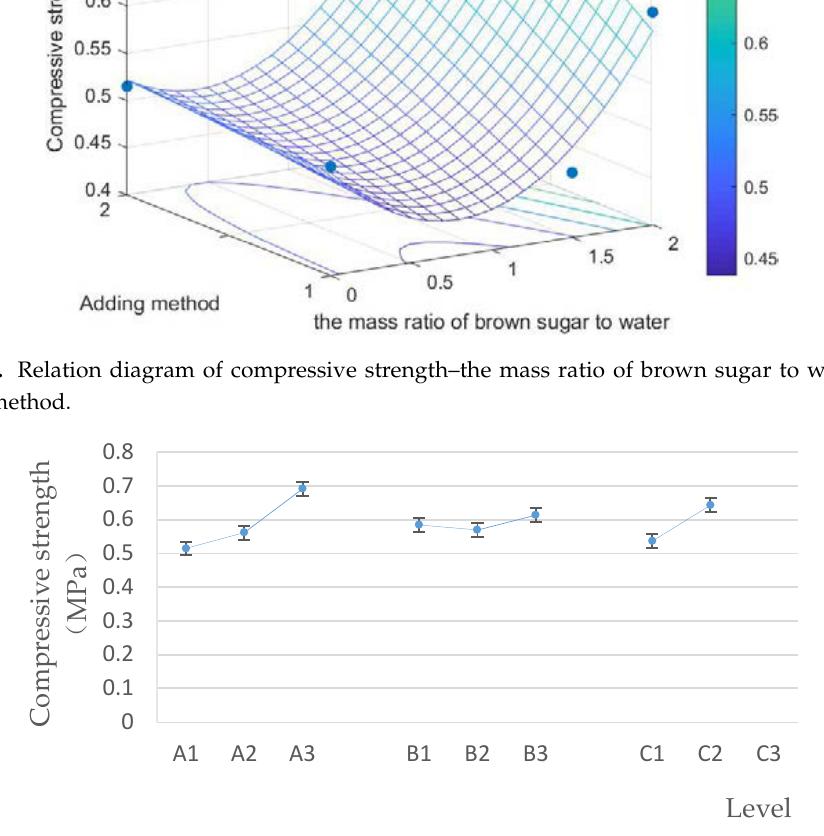
Figure 5. Factors and levels–compressive strength.